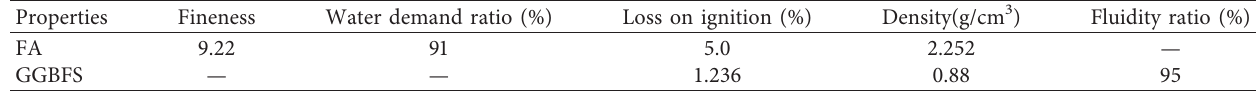
Table 2: Main properties of FA and GGBFS.